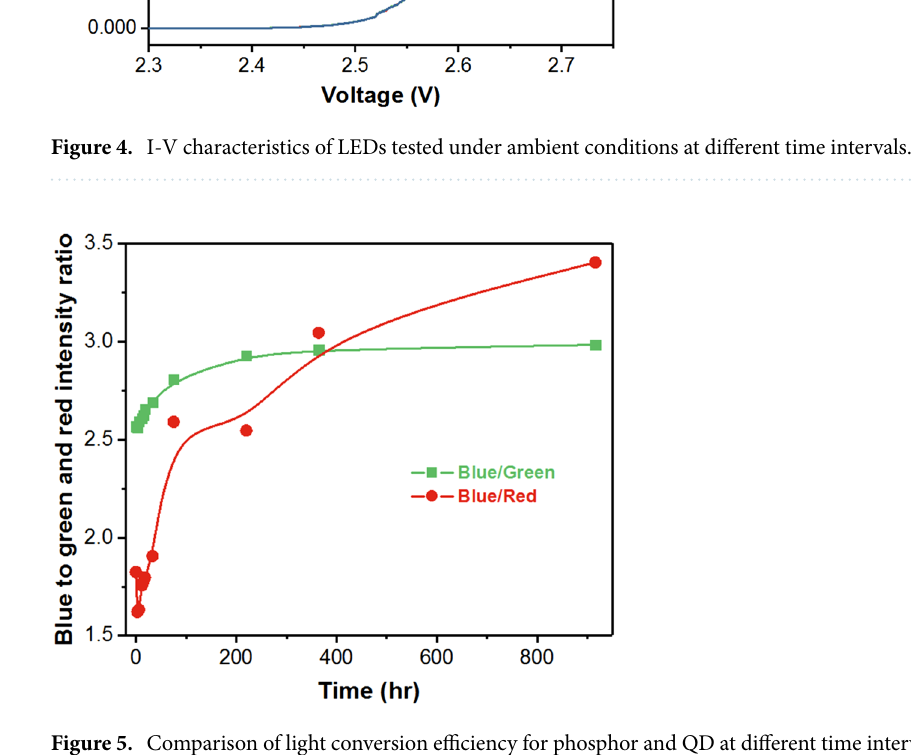
Figure 5. Comparison of light conversion efficiency for phosphor and QD at different time intervals in a packaged LED.